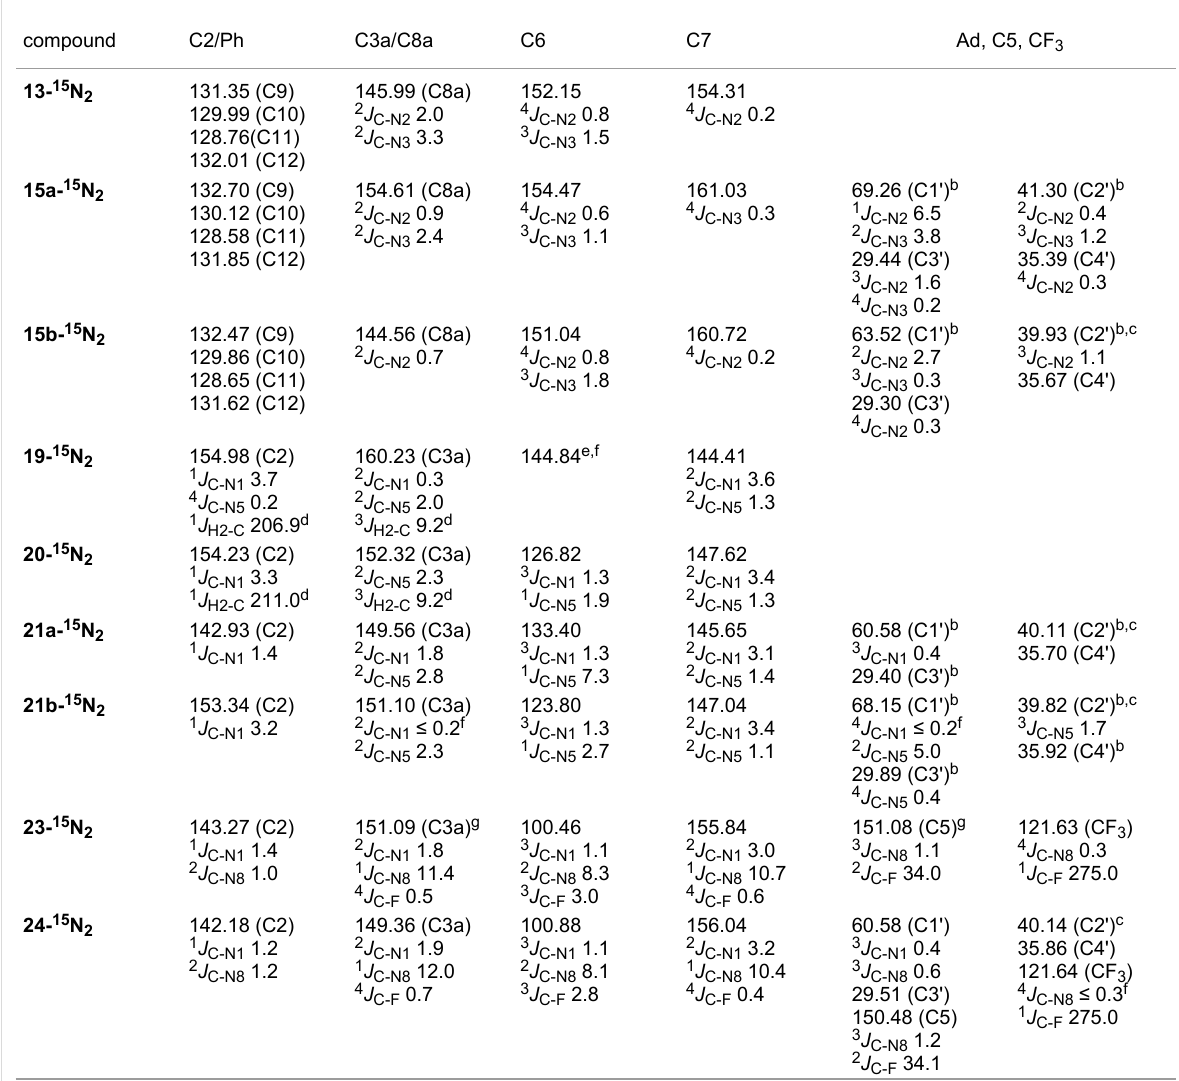
Table 2: 13 С Chemical shifts (ppm) and 1 H- 13 C, 13 C- 15 N and 13 C- 19 F J -coupling constants (Hz) of the studied compounds a .